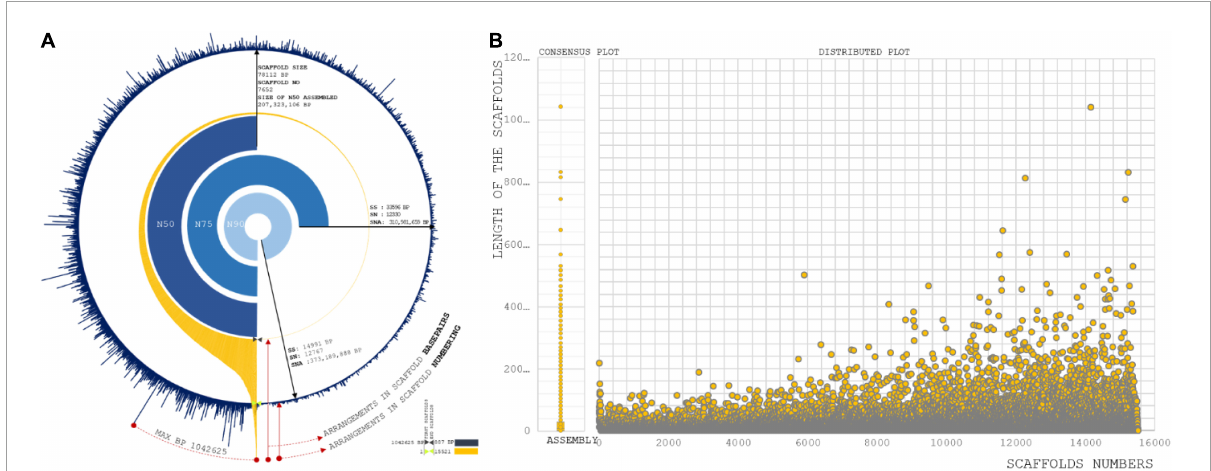
FIGURE1 (A) Assembly summation statistics: First layer (Blue) exhibit the distribution of scaffold number orderly over completeness of 15,221 scaffold reads. Second layer (Orange) are the arrangement of scaffolds with respect to base pair length. Internal three layers are representing N50, N75, and N90 statistic of our assembly with scaffold size, scaffold position, and size of summation statistics. (B) Sequence assembly length distribution coordinated from scaffold numbers to length of the sequence in each